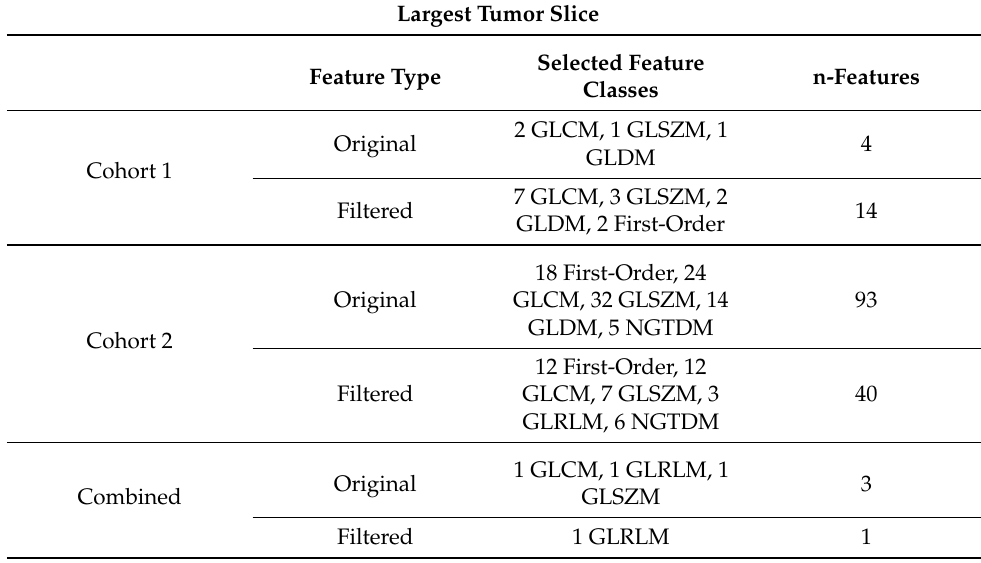
Table 4. Representation of robust features selected for Largest Tumor Slice.